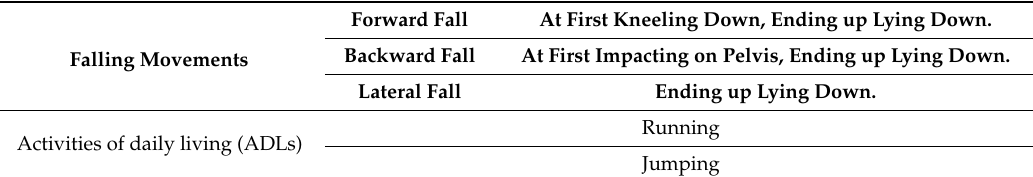
Table 3. Falling movements and activities of daily living conducted in experiments. Forward fall Falling Movements